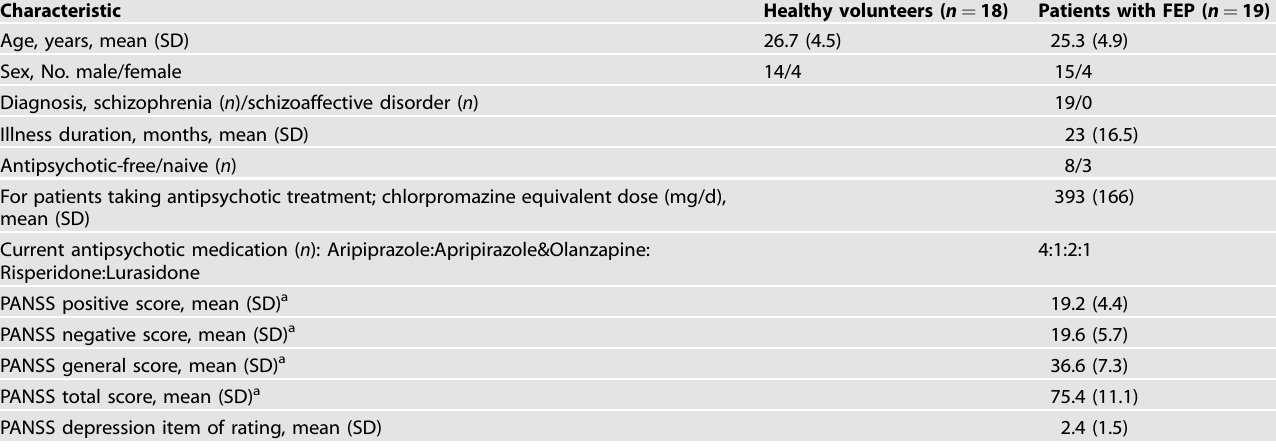
FEP fi rst-episode psychosis, Shaded box not applicable, PANSS Positive and Negative Syndrome Scale, SD standard deviation, n number. a Scores range for total PANSS: 53 – 88, general PANSS subscale: 25 – 46, positive subscale of the PANSS: 12 – 27; negative subscale of the PANSS: 8 – 28; and depression item: 1 – 6. Higher scores indicate greater symptom